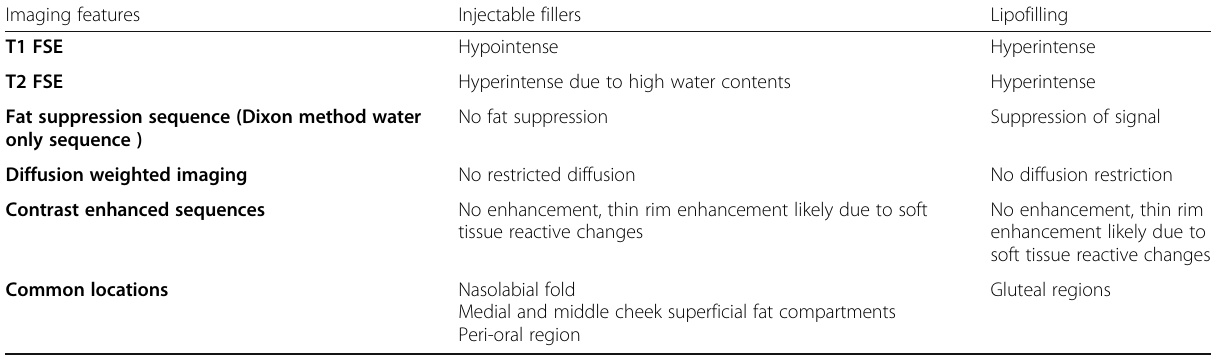
Table 2 Diagnostic features of fillers in the studied patients Imaging features